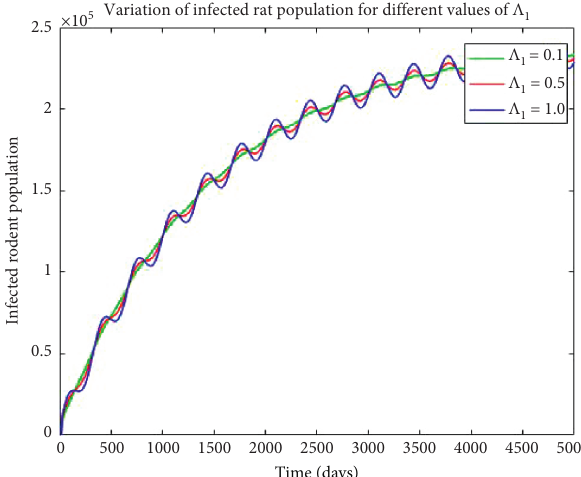
Figure 3: Behaviour of the time-dependent per capita birth rate of mastomys natalensis rat as it varies with different values of λ � 0 . 1, Λ � 0 . 5, Λ � 1 . 0. that Λ 1 1 1